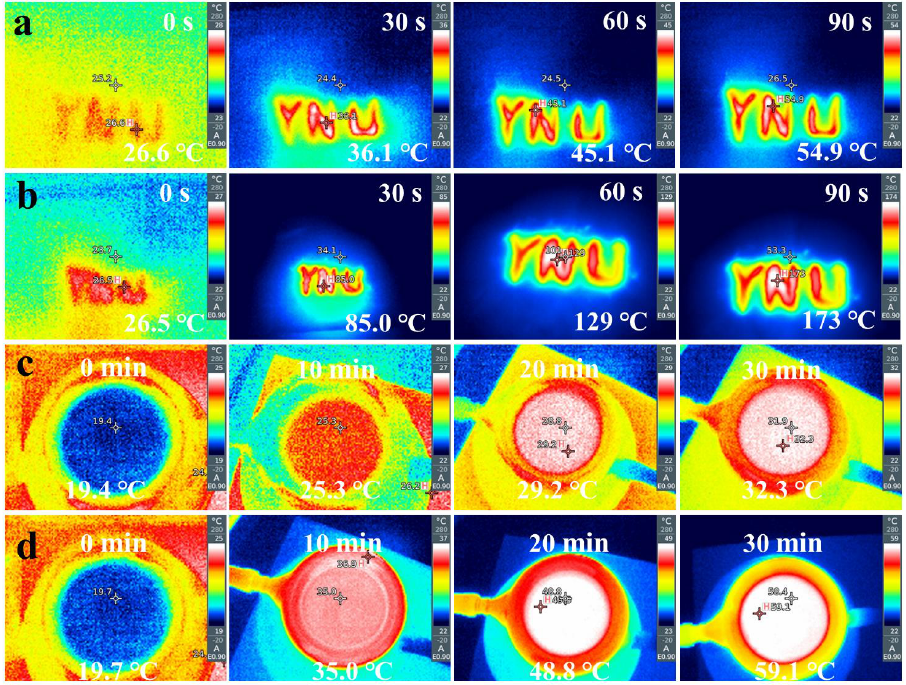
Figure 5. Temperature-light time trends of g-C 3 N 4 ( a ), Ag/α -Fe 2 O 3 /g-C 3 N 4 ( b ) in the air. Temperature-light time trends of g-C 3 N 4 ( c ), Ag/α -Fe 2 O 3 /g-C 3 N 4 ( d ) in the water.